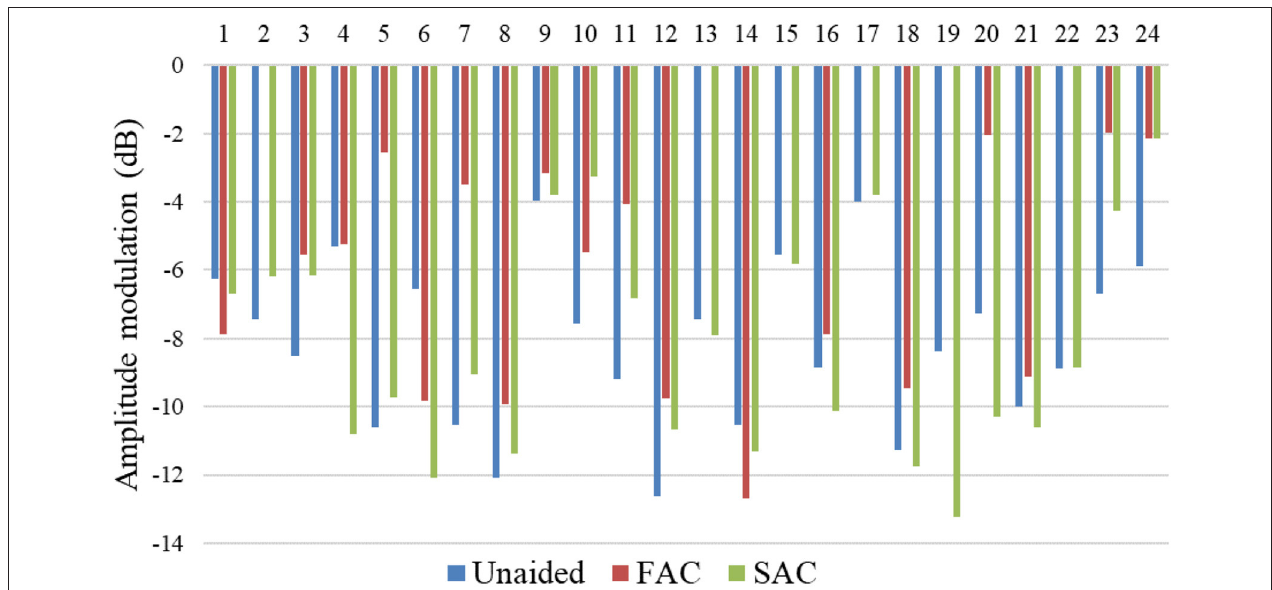
FIGURE 2 | Temporal modulation discrimination thresholds measured across